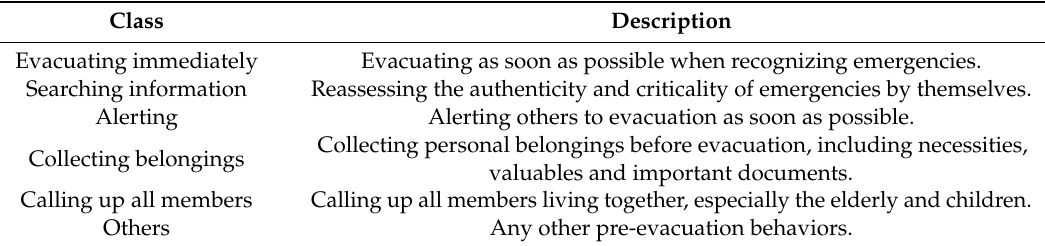
Table 3. The description of pre-evacuation behaviors.